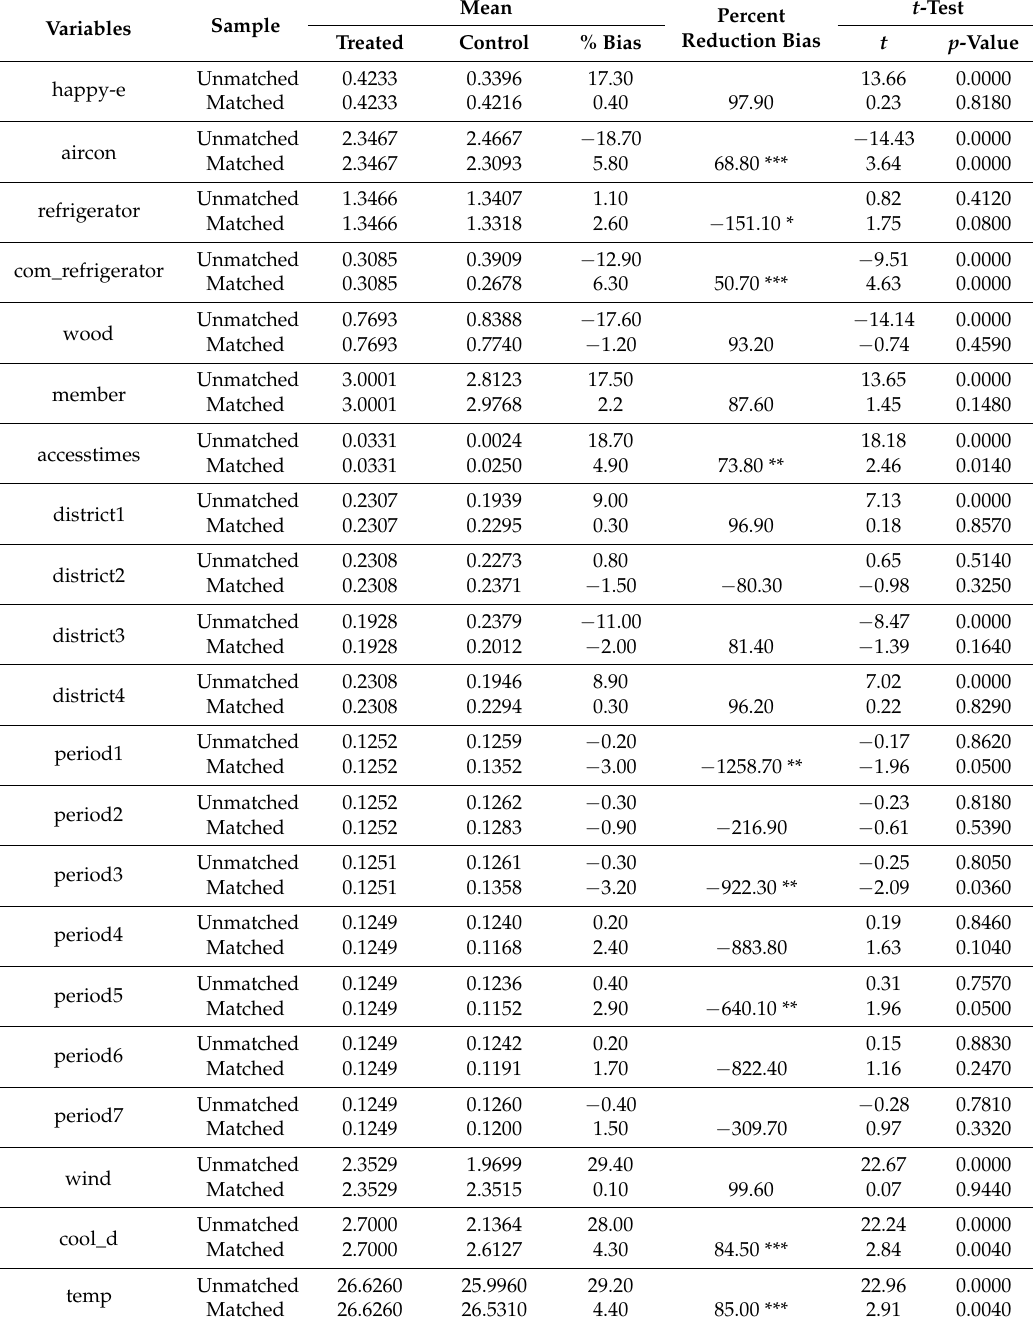
Table A1. Result of balancing test of propensity score model of Treateffect